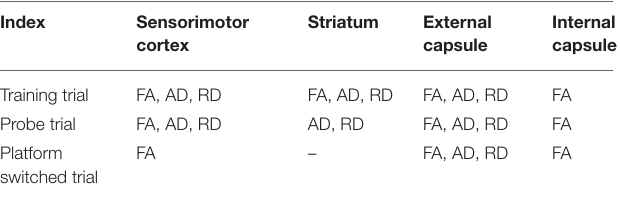
TABLE 2 | The summary of significant correlations between the MWM and DTI